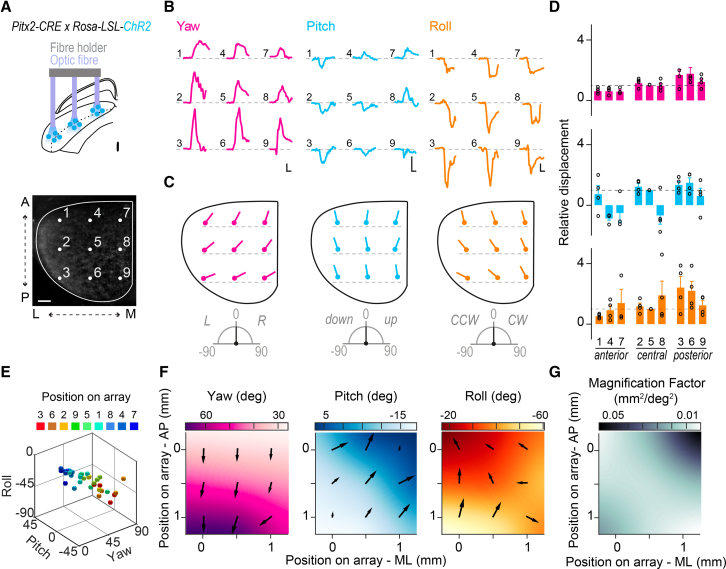
Pitx2ON Modules Define a Motor Map for Head Movements(A) Schematic of the optic fiber array (top) with fiber reference numbers (center) and schematic representation of array placement in the SC (top view) in a Pitx2-CRE::Rosa-LSL-tdTomato clarified brain (scale bar: 250 μm) (bottom).(B) Representative traces of the light-triggered three-dimensional head movement for each site decomposed in yaw (magenta), pitch (blue), and roll (orange) components (scale bars: 200 ms, 20 degrees).(C) Average movement vector produced in yaw (left; left [L] and right [R] movements), pitch (center; up or down movements), and roll (right; counter-clockwise [CCW] or clockwise [CW] movements) by light stimulation of nine SC locations from one representative animal shown in (B).(D) Average amplitude of the light-driven displacement for each site and each Eulerian component, relative to the amplitude of head displacement generated at position 5 within each array (nTRIALS/POSITION = 40; nMICE = 4). Statistically significant comparisons are, for yaw, Pos1–3 (p = 0.04), Pos1–6 (p = 0.03), Pos3–4 (p = 0.04), Pos4–6 (p = 0.02), Pos6–7 (p = 0.04); for pitch, Pos2–4 (p = 0.03), Pos3–4 (p = 0.02), Pos3–8 (p = 0.04), Pos4–6 (p = 0.01), Pos6–8 (p = 0.03). All results are presented as mean ± SEM.(E) 3D representation of joint yaw, pitch, and roll movements across the nine SC sites studied. Each sphere represents the average movement vector produced in yaw, pitch, and roll for each animal (nTRIALS/POSITION = 40; nMICE = 4).(F) Average movement vectors produced in yaw (magenta), pitch (cyan), and roll (orange) across the nine SC sites represented in color-coded maps. The maps were smoothed and interpolated to emphasize the changes in degrees across the medial-lateral and anterior-posterior SC. Black arrows indicate the direction of local gradient for yaw (left), pitch (center), and roll (right) computed at each location of the array (AP, anterior-posterior; ML, medial-lateral). The length of the arrow indicates the rate of change of the angle over the SC surface.(G) Magnification factor map computed from the maps of yaw and pitch (in mm2/deg2). At each location, the magnification factor indicates how finely angular movements are represented over the SC surface (AP, anterior-posterior; ML, medial-lateral).See also Figure S4.